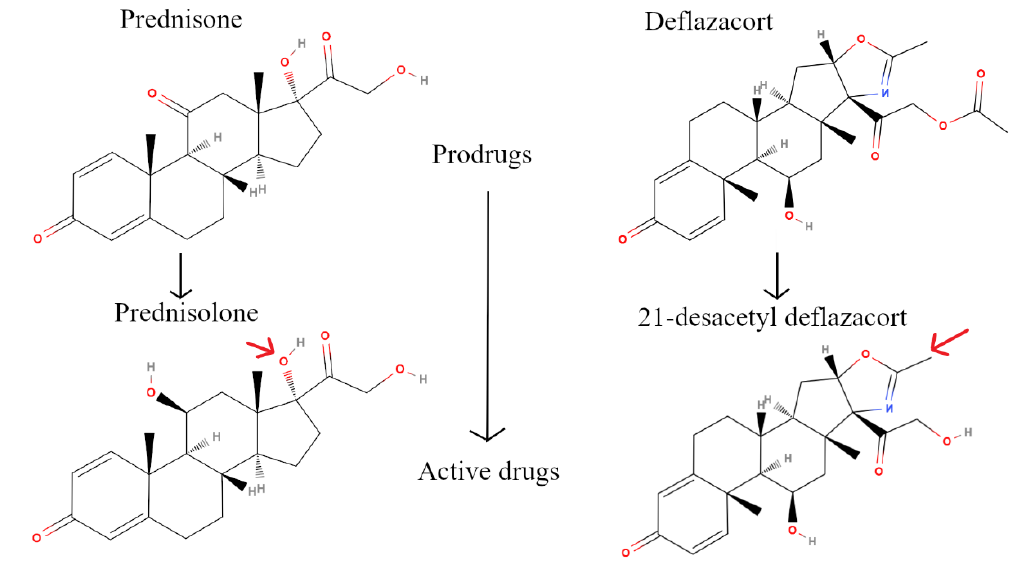
Figure 1. 2D structures of Prednisone and Deflazacort (top panels) and their active drugs: prednisolone and 21-desacetyl deflazacort. The similarities are clear. The red arrows point to the structural differences between the active drugs.